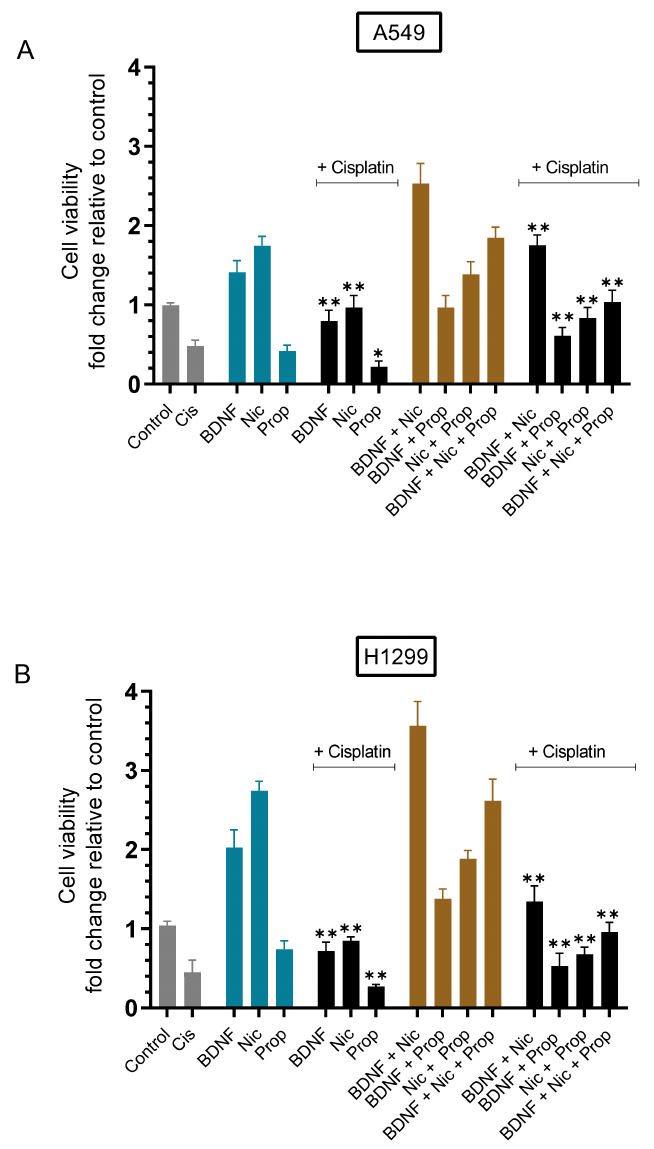
Figure 2. Treatment with propranolol reversed the increase in cell viability measured by treatment with either BDNF or nicotine in the absence or presence of cisplatin. Cells (0.2 × 10 5 ) were grown in 10%